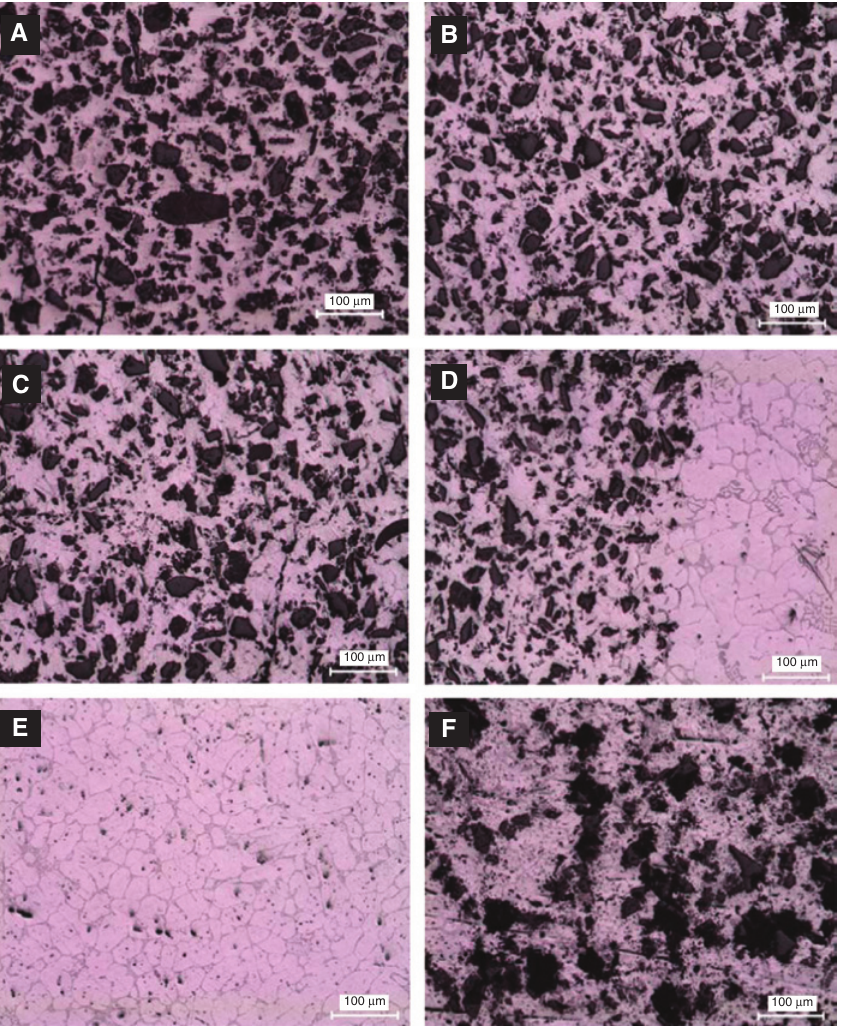
Figure 5 Microstructure image of the composite located at different regions from external to the internal zone: (A) 1 mm, (B) 3 mm, (C) 4 mm, (D) x = 7 mm, (E) x = 15 mm, and (F) x = 55 mm.